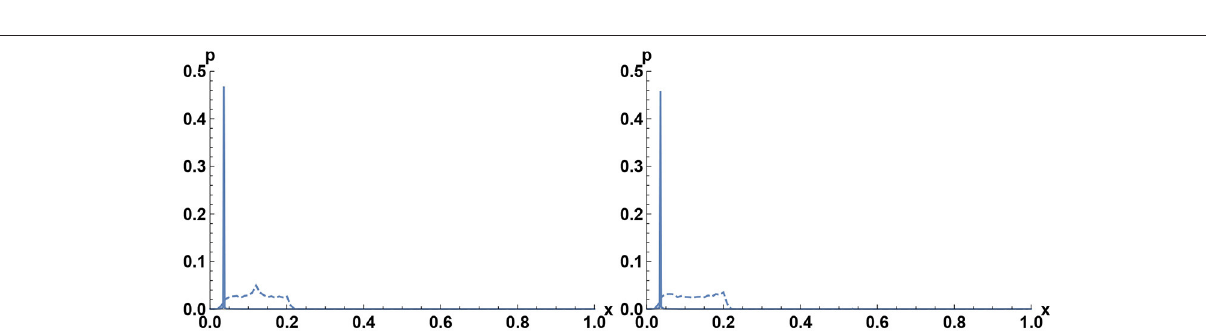
FIGURE 1 | The numerical results for probability distribution of x = α/ (2 π ). The smooth line is ρ 0 ( x ), the dashed line ρ 1 ( x ). (Left) q 01 = q 10 = 0.005, and (Right) q 01 = q 10 = 0.010.